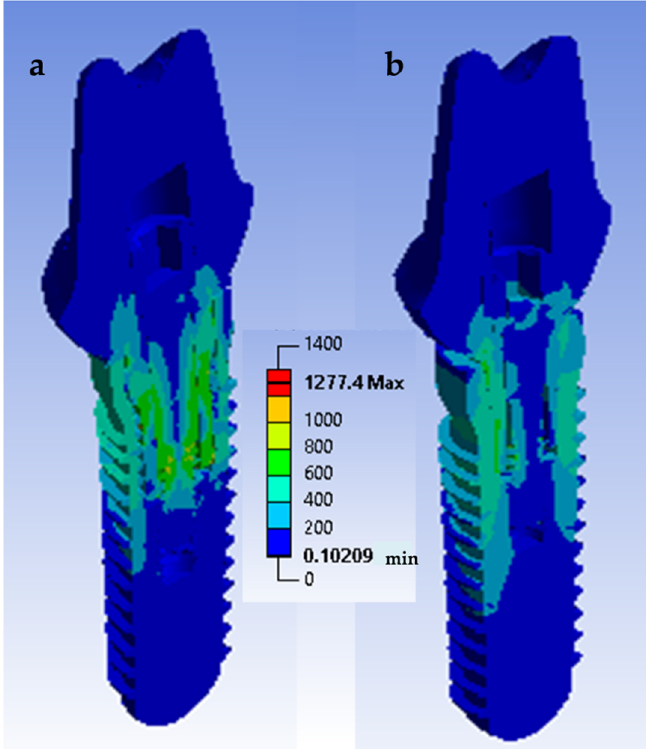
Figure 7. Von Mises stress distributions for ( a ) tube in tube connection and ( b ) conical connection with platform switching. A compression load of 900 N was applied to the surface of the restoration.